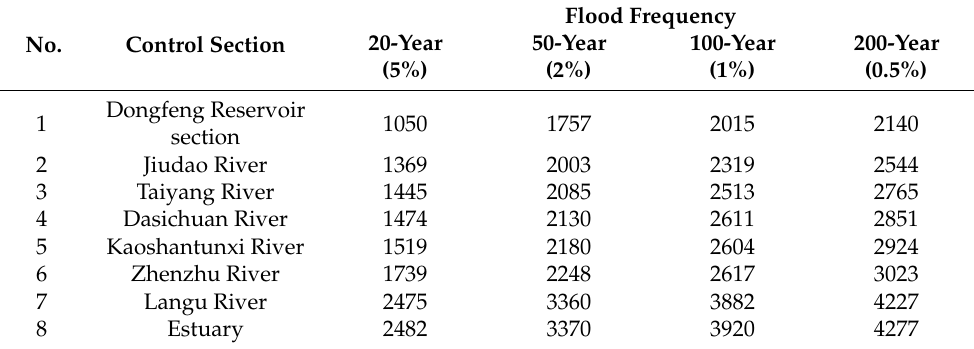
Table 2. Calculation results of peak discharge in each control section m 3